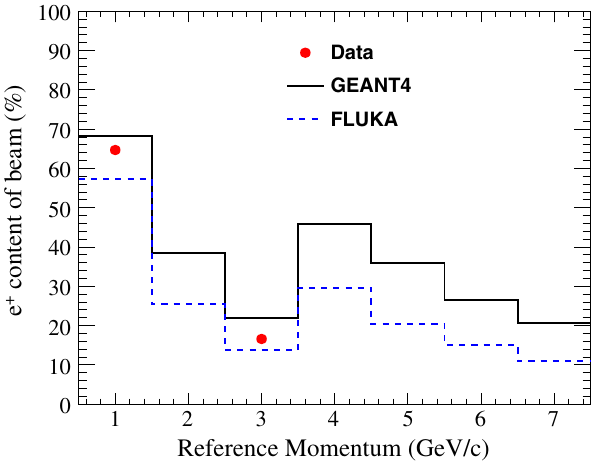
FIG. 19. Measured and simulated trigger rates, in all momenta. The W target has been used for the momenta ≤ 3 GeV =c and the Cu target for the momenta above 3 GeV =c . A 90 % overall trigger efficiency has been assumed, as discussed in the text.